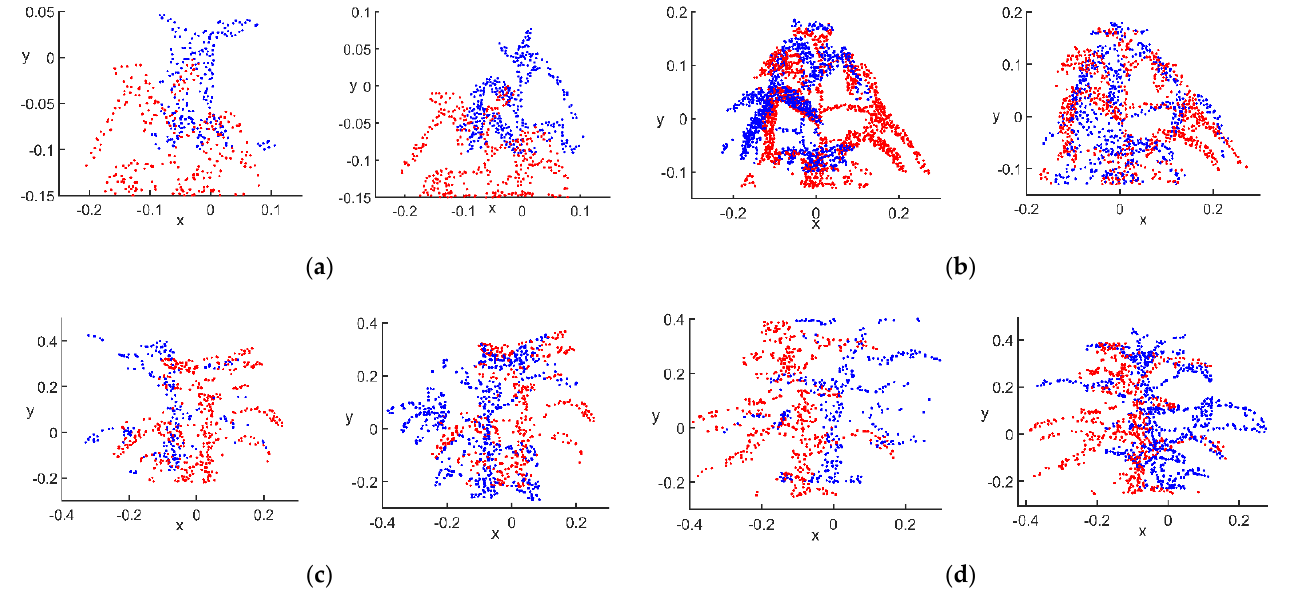
Figure 8. Selection of feature point sets: ( a ) flowering stage; ( b ) podding stage; ( c ) filling stage; ( d ) mature stage.